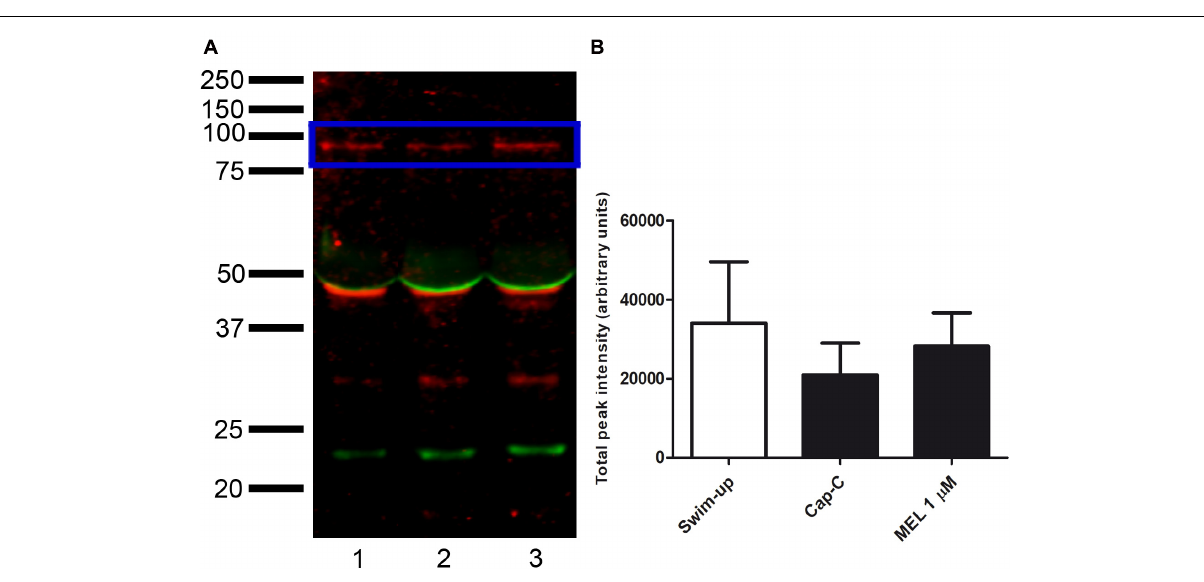
FIGURE 9 | (A) Western blot analysis of the presence of NADPH oxidase 5 (blue box) in swim-up selected (lane 1) and incubated 3 h in capacitating conditions with cAMP-elevating agents (Cap-C, lane 2) ram spermatozoa protein extracts. Effect of melatonin 1 µ M (MEL 1 µ M) in capacitated samples with high cAMP (lane 3). (B) Densitometry quantification of NOX5 normalized to α -tubulin (loading control, orange box) ( n =